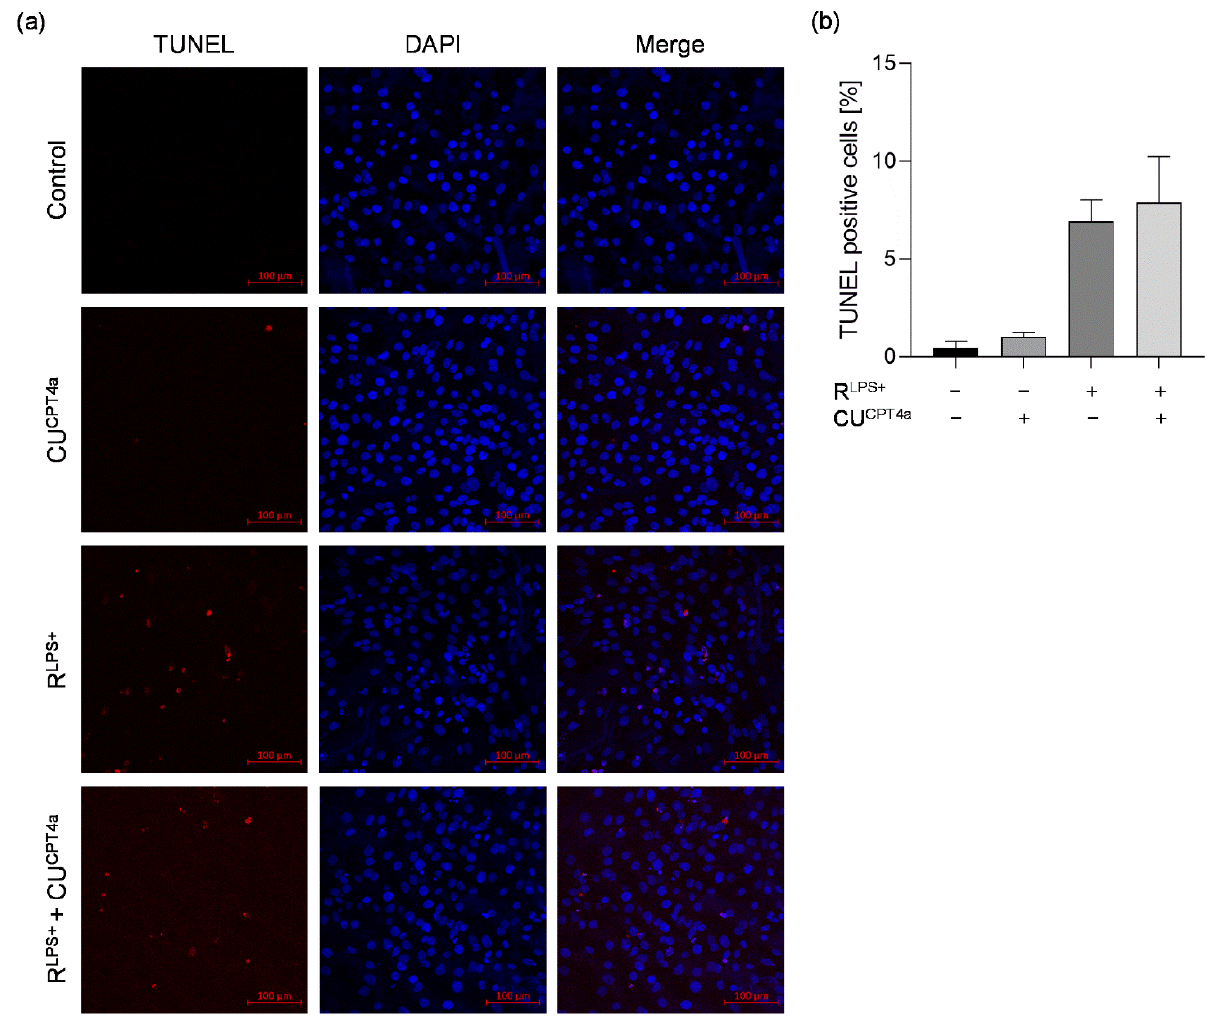
Figure 3. Treatment of cardiomyocytes with conditioned medium of LPS-stimulated macrophages results in increased cardiac apoptosis via a TLR3-independent pathway. Cardiomyocytes exposed to conditioned medium of LPS-stimulated macrophages in the presence (R LPS+ + CU CPT4a ) or absence (R LPS+ ) of 40 µM TLR3 inhibitor CU CPT4a for 24 h compared with unstimulated cells (control) and 40 µM TLR3 inhibitor CU CPT4a (CU CPT4a ) were analyzed using TUNEL labeling (n = 2). ( a ) Apoptotic cells were labeled with TUNEL (red) and the nuclei of cardiomyocytes were stained with DAPI (blue). Scale bars: 100 µm. ( b ) Quantification of TUNEL fluorescence. Data are presented as column bar graph as the mean ± SD. LPS = lipopolysaccharide; TLR3 = toll-like receptor 3.